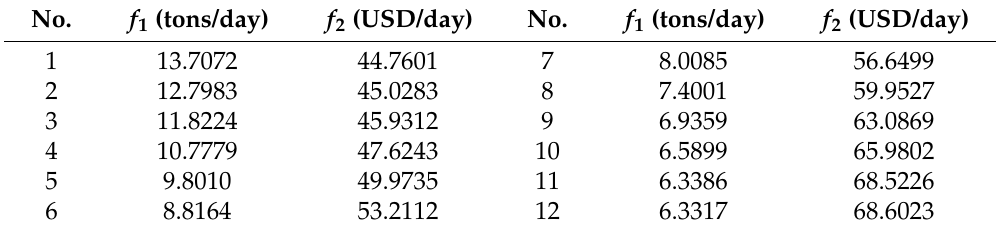
Table 4. List of solutions of the Pareto front of Figure 3.